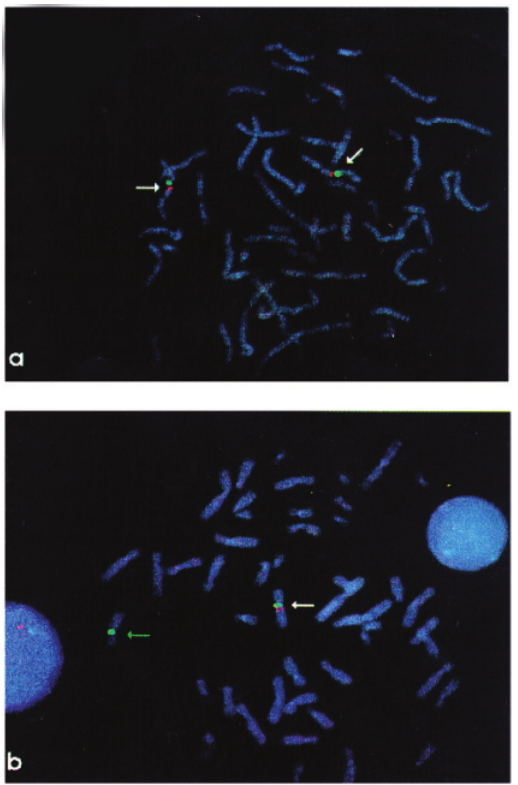
Figure 1 - Region 7q11.23 on the long arm of chromosome 7 and probe VYSIS ® LSI Williams Syndrome